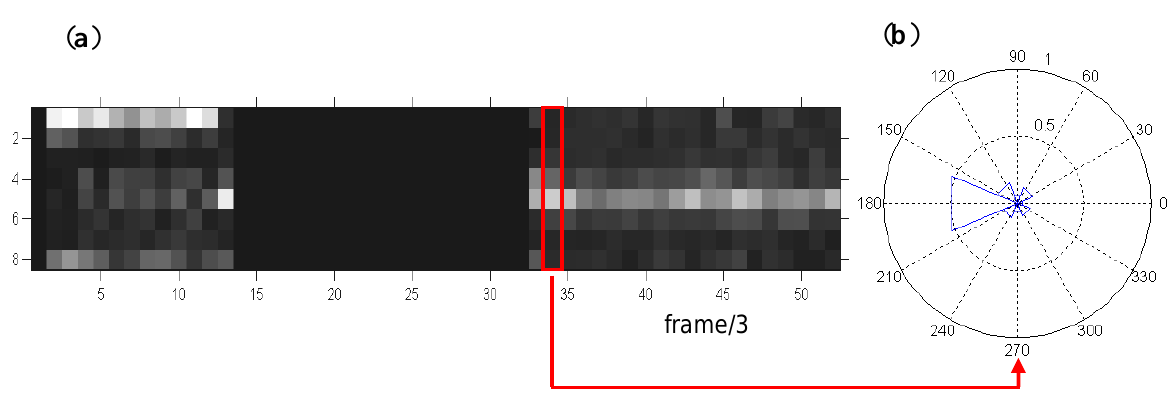
Figure 4 . ( a ) Representation of the movie part by means of histograms of OF directions: motion to the right side of the scene corresponds to histogram bin equal to 1 (B1), motion to the left–bin equal to 5 (B5). Frames 1–13–a person is running to the right, 14–32–the scene contains only a static background, 33–52–a person is walking to the left, ( b ) Histogram of optical flow directions calculated within the dilated edge of the object (polar